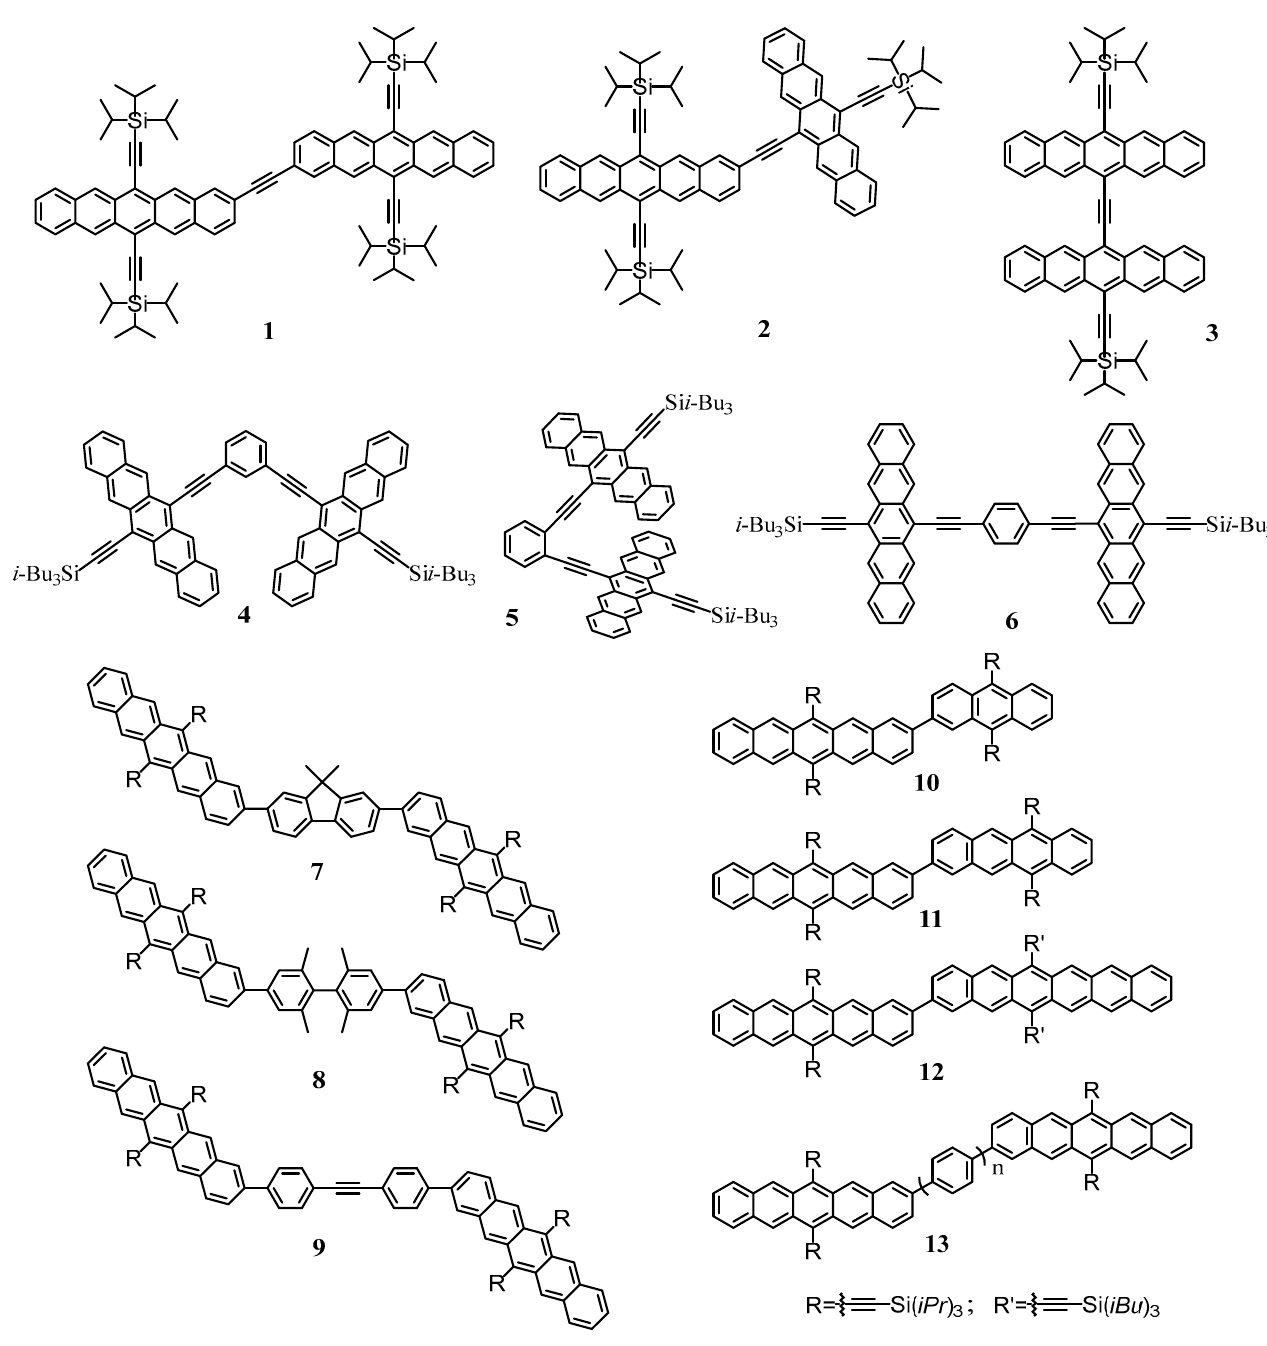
Figure 5. Structures of partial pentacene dimers considered in this review.